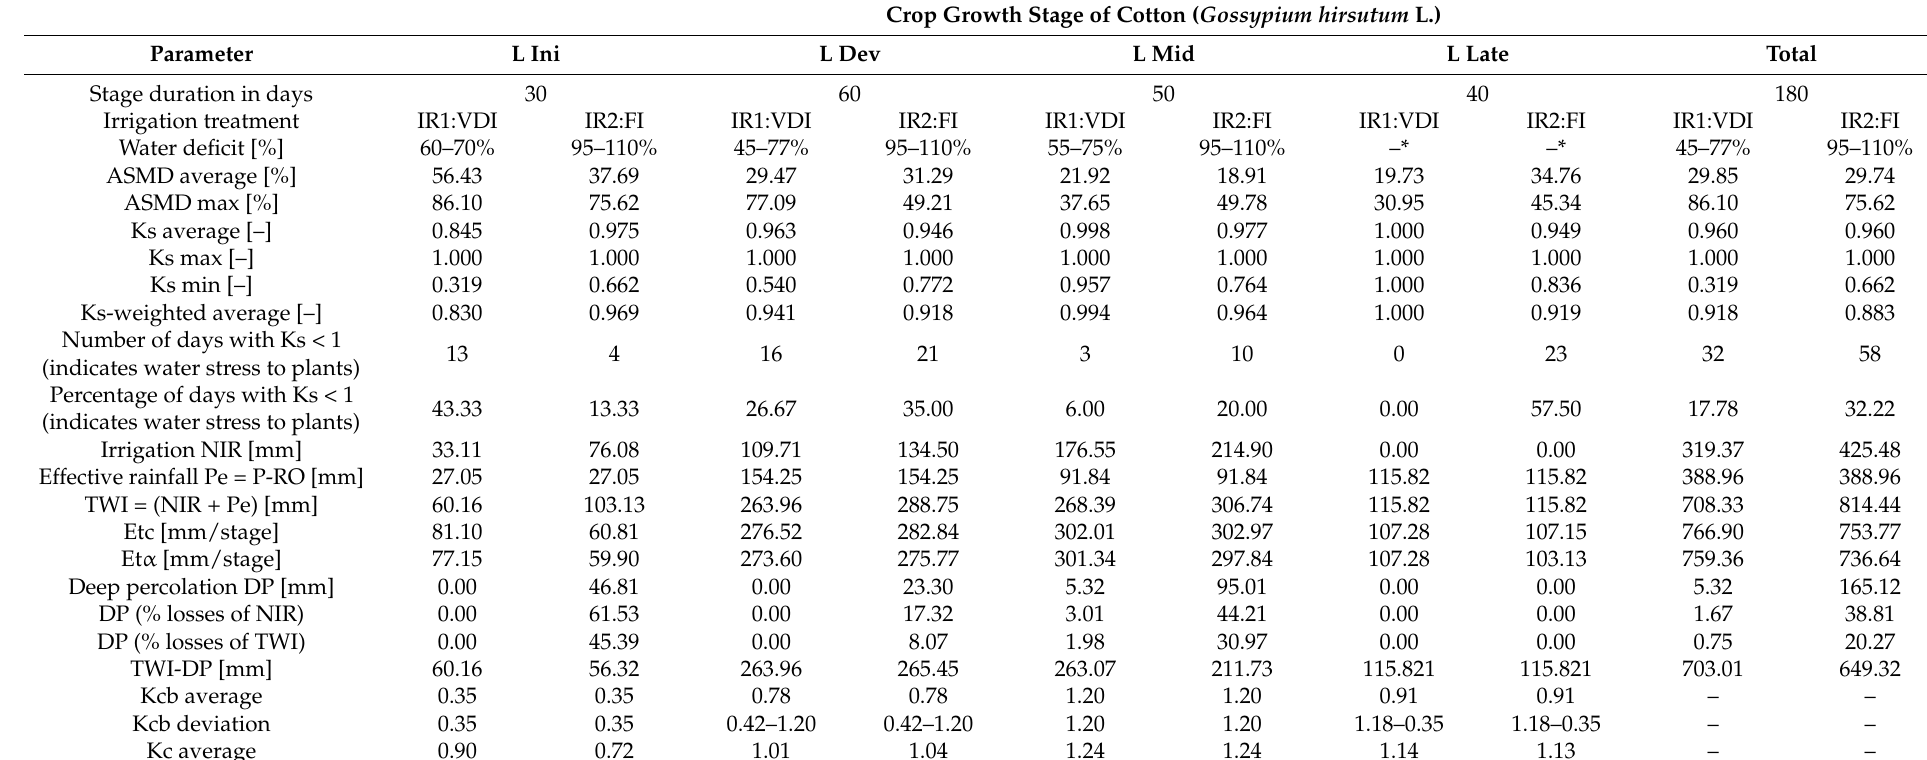
Table 3. Crop growth stage parameters and results of the SWCA model and the depletion model. Crop Growth Stage of Cotton ( Gossypium hirsutum